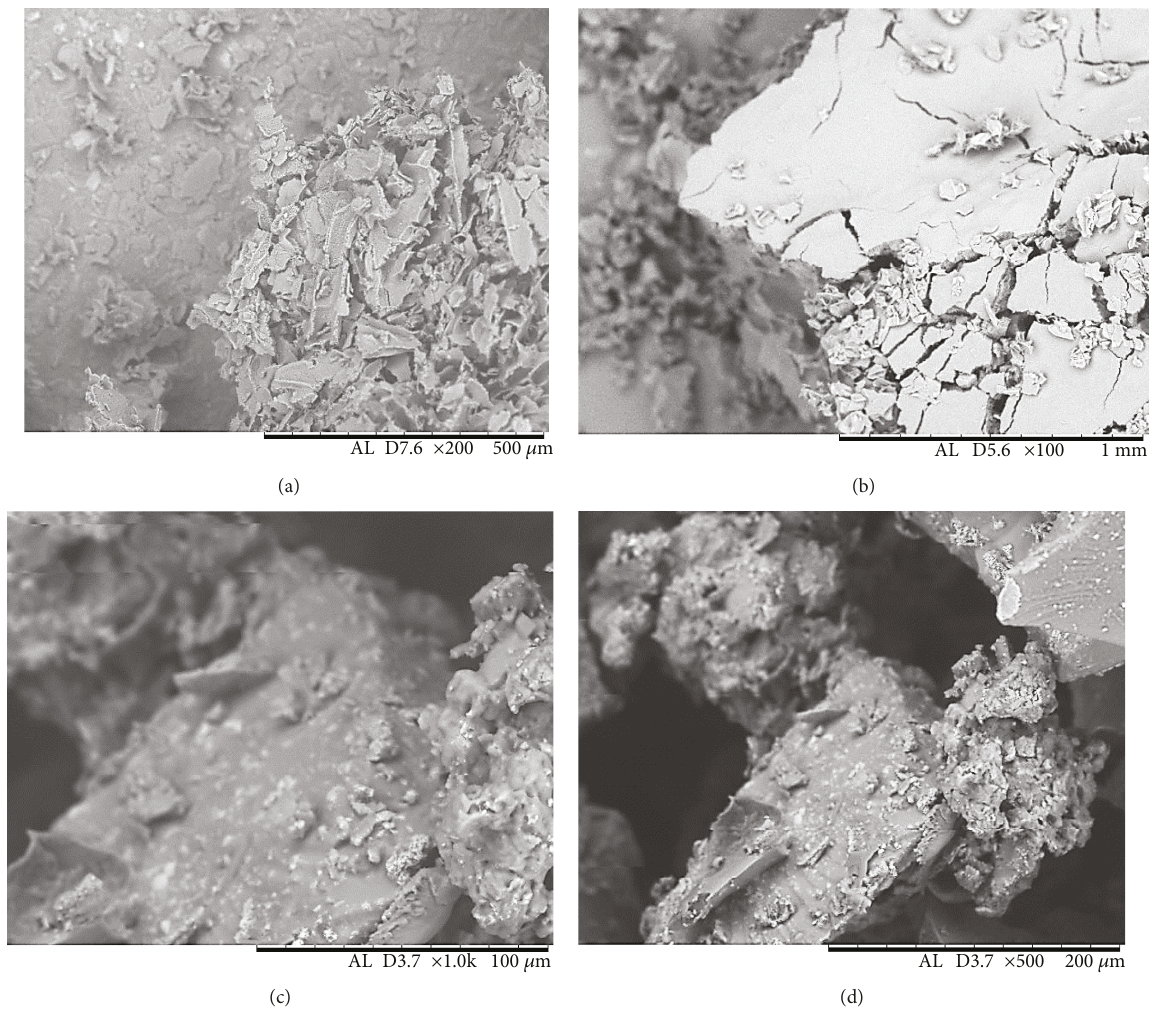
Figure 11: SEM micrographs of Poly (CMCS- g -AA) hydrogels. Surface morphology of blank hydrogel sample (a). Surface morphology of drug-loaded hydrogel sample (b). Cross-sectional morphology of blank hydrogel sample (c). Cross-sectional morphology of drug-loaded hydrogel sample